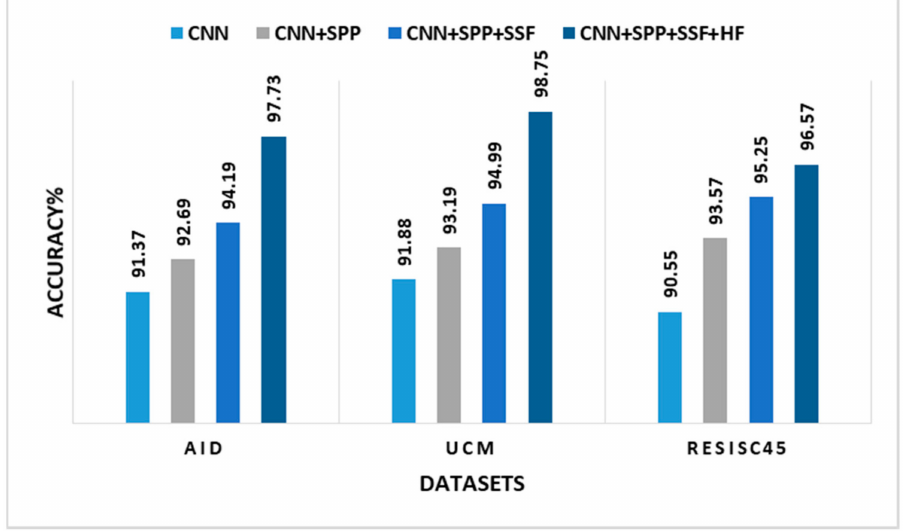
Figure 16. Recognition accuracies of OCSC model over three benchmark datasets using feature fusion under greedy approach.